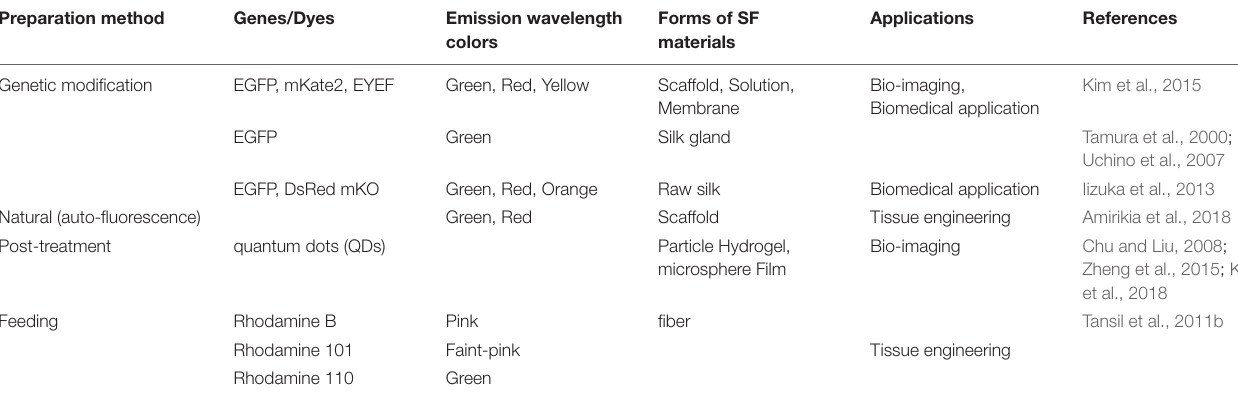
FIGURE 1 | Colored Fluorescent Silk Made by Transgenic Silkworms. (A) Colored fluorescent cocoons and (B) cross-section of the cocoon silk produced by the hybrid races. (C) Fluorescent silks. (D) Wedding dress made by the colored fluorescent silks. Reproduced from Iizuka et al. (2013) with permission from John Wiley and Sons. TABLE 1 | A brief summary of fluorescent SF-based materials and their potential biomedical